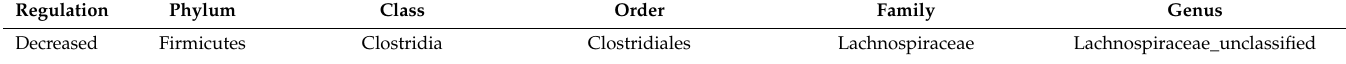
Table 2. Operational taxonomic units (OUT) abundance significantly modified by age a, b